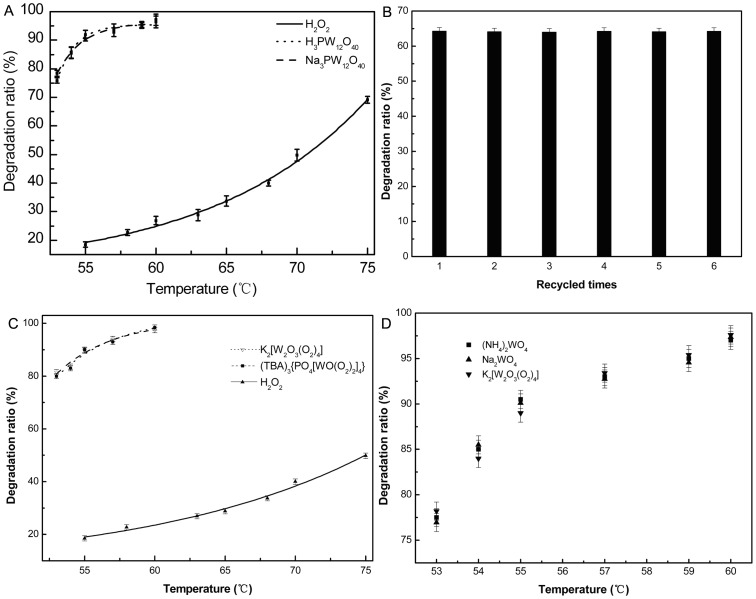
The oxidative degradation of chitosan, (A) H3PW12O40 (0.35 µmol), Na3PW12O40 (0.35 µmol) and H2O2 without any additives.(C) (TBA)3{PO4[WO(O2)2]4} (1.05 µmol), K2[W2O3(O2)4] (2.1 µmol) and H2O2 without any additives. (D) Na2WO4 (4.2 µmol), (NH4)2WO4 (4. 2 µmol) and K2[W2O3(O2)4] (2.1 µmol). Under the same reaction conditions: H2O2 (1 mL), H2O(5 mL), 20 min. (B) Recycling of the filtrate at 65°C, 1 mL H2O2.